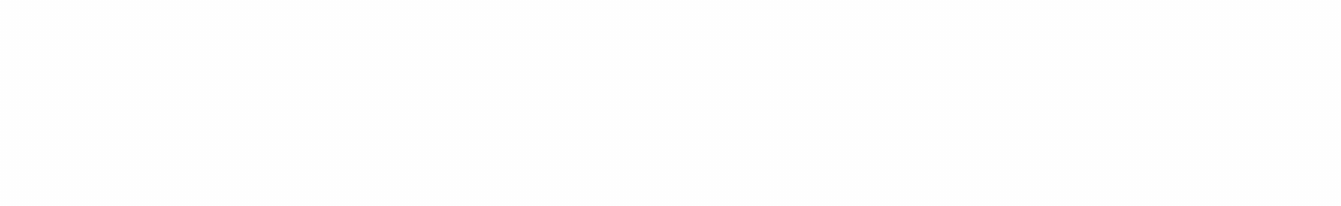
FIGURE 3 Calculation results of the characteristics for the Lozi attractor. (a) A distribution of the probabilities of the angle 4) between stable and unstable manifolds for a 1.7 and b=0.3, (b) a plot of the minimal angle mi,, versus parameter a for b=0.3 and (c) a dependence of the largest Lyapunov exponent on a for b